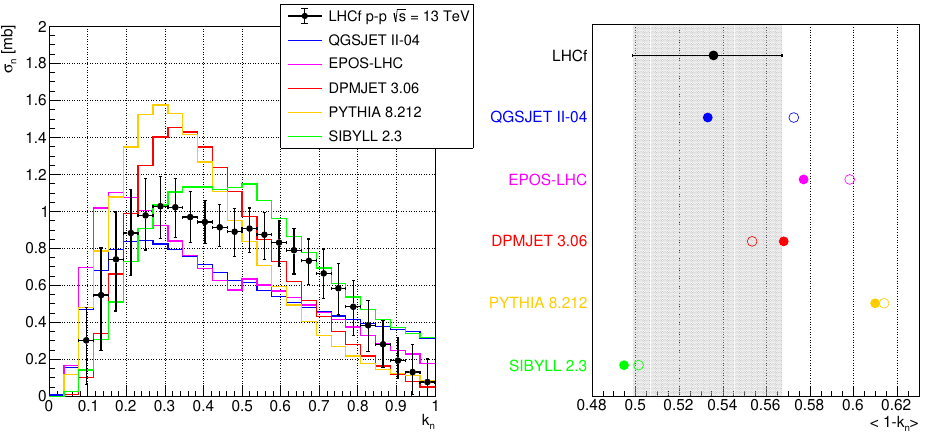
Figure 4 . Inclusive production cross section as a function of elasticity k n (left) and average inelasticity h 1 (cid:0) k n i extracted from that distribution (right), relative to p-p collisions at These quantities, measured using the LHCf Arm2 detector, are only relative to the events where the leading particle is a neutron. Black markers represent the experimental data with the quadratic sum of statistical and systematic uncertainties. Solid lines (left) and full circles (right) refer to model predictions at the generator level, obtained using only the events where the leading particle is a neutron. In order to compare this approach to the general case, h 1 (cid:0) k i , the average inelasticity obtained using all the events independently of the nature of the leading particle, is also reported as open circles in the right